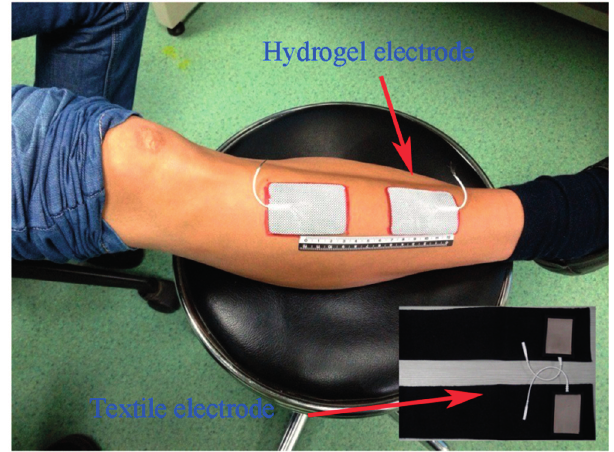
Figure 2. Placement of electrodes for impedance spectroscopy measurement.